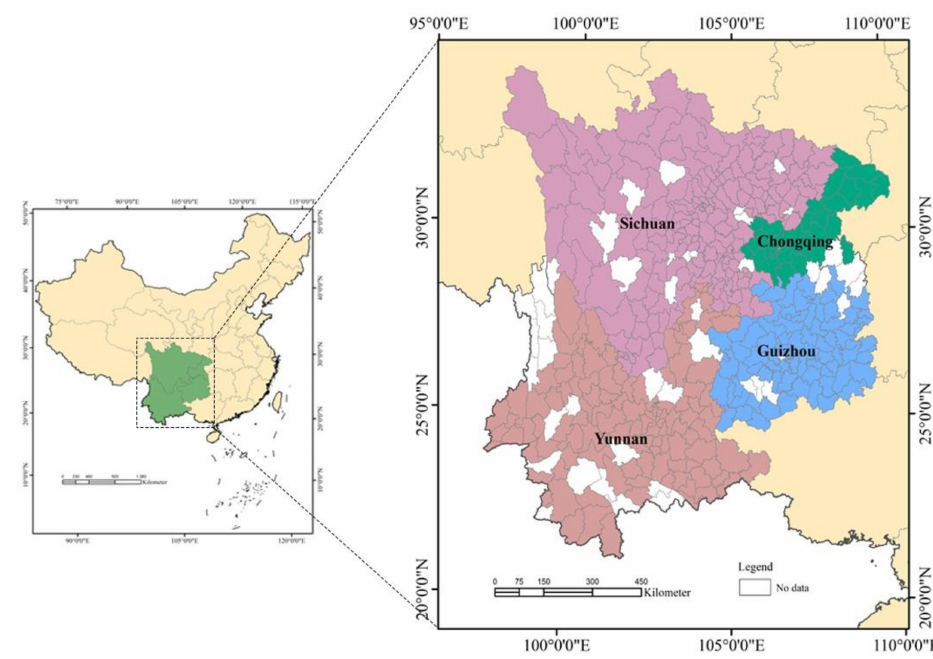
Figure 1. Location of Southwest China.